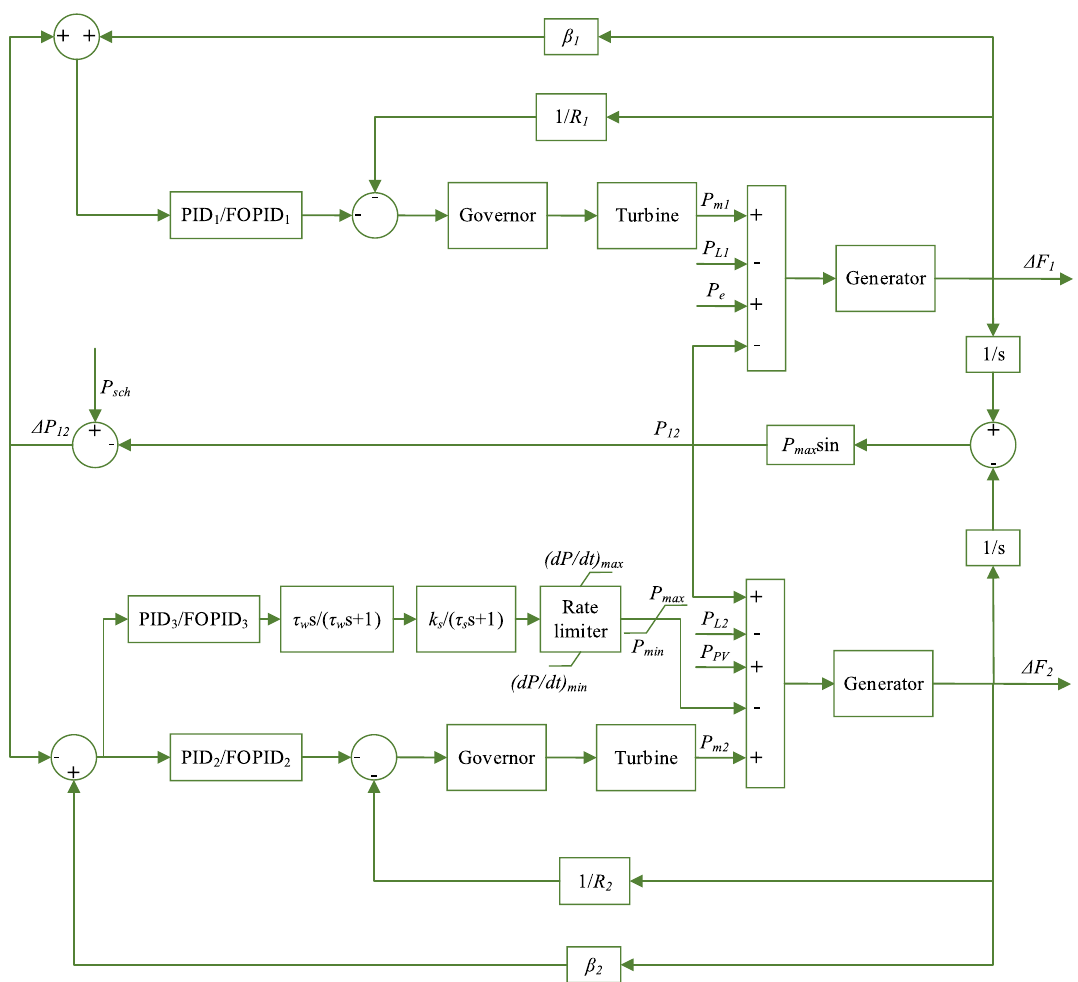
Fig. 1 Block diagram model of the studied two‑area power